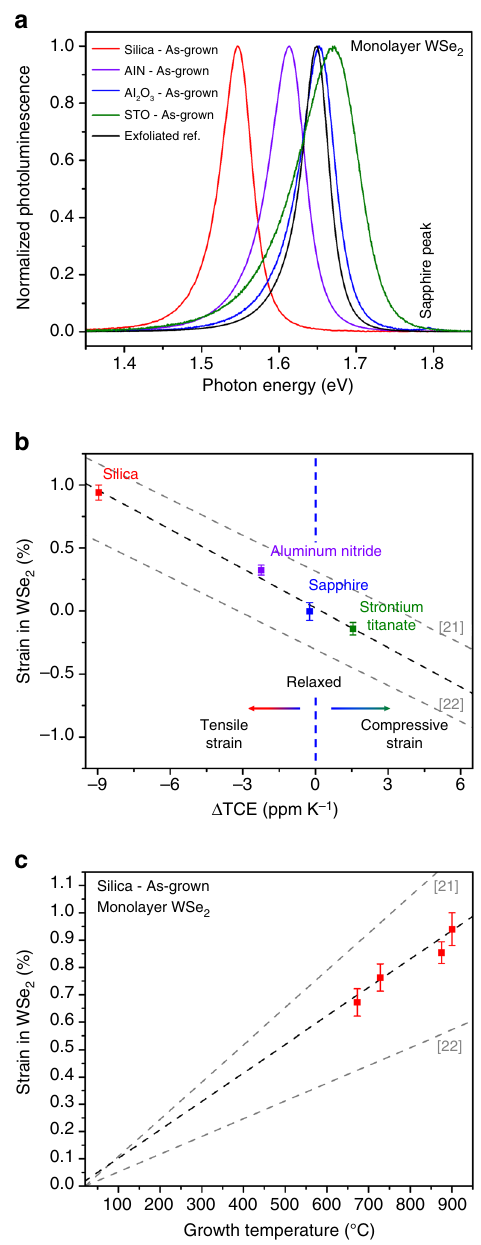
Fig. 3 Strain engineering of 2D materials. a PL spectra for monolayer WSe 2 as-grown on substrates with a range of thermal coef fi cient of expansion mismatches. b Estimated strain that can be achieved in 2D materials based on the mismatch between the substrate and TMDC thermal coef fi cient of expansion; data points show measured strain for substrates with a range of thermal expansion coef fi cient mismatch; dashed gray lines are based on TCE values for WSe 2 obtained from refs 21, 22 , dashed black line shows fi t to experimental data. c Estimated strain realized in WSe 2 as-grown on fused silica at various substrate temperatures; dashed gray lines are based on TCE values for WSe 2 obtained from refs 21, 22 , dashed black line shows fi t to experimental data. Error bars indicate standard deviation of strain, measured over fi fteen